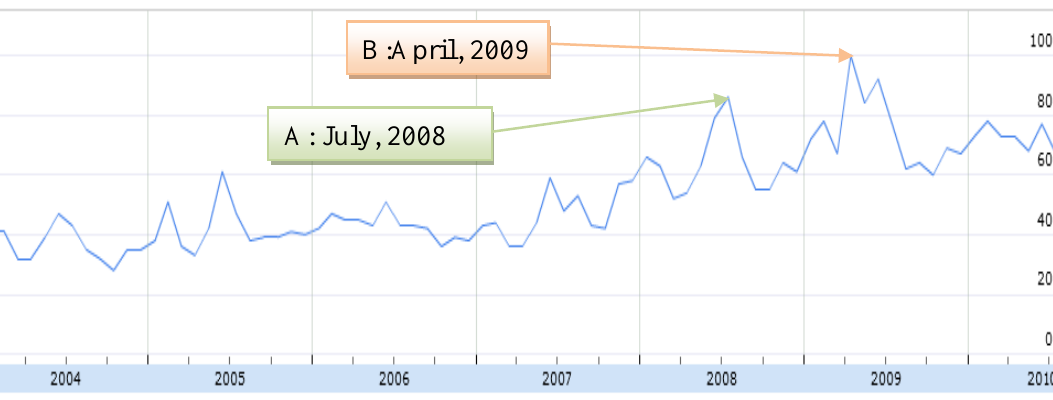
Figure 5. Index of interest shown in search term “Shoene” ( Graph generated by Google Insights for Search on 19 July 2010